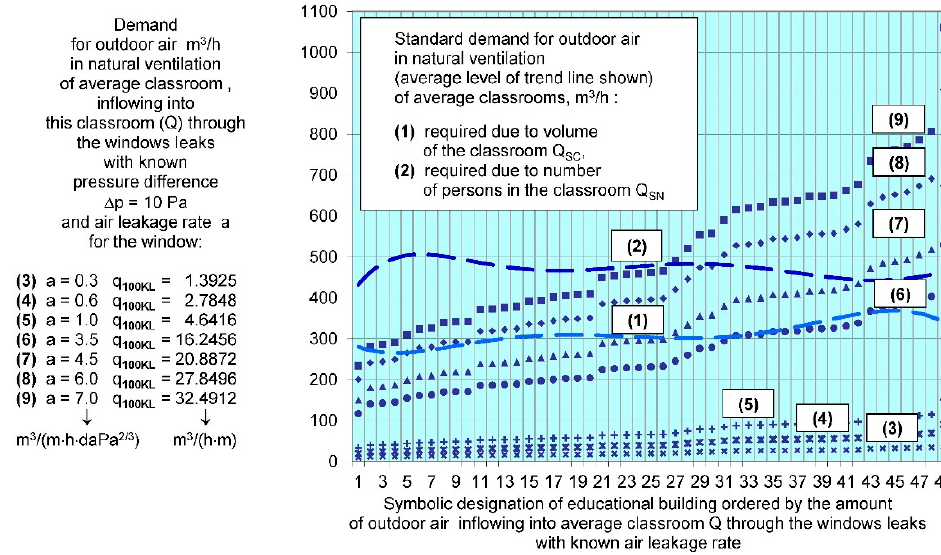
Figure 15. The quantity of air flowing into the classroom from the outside through the windows with different rates of outdoor air leakage a , in m 3 /(m h daPa 2/3 ) and their corresponding outdoor air permeability q 100KL in m 3 /(h · m) for ∆ p = 10 Pa.